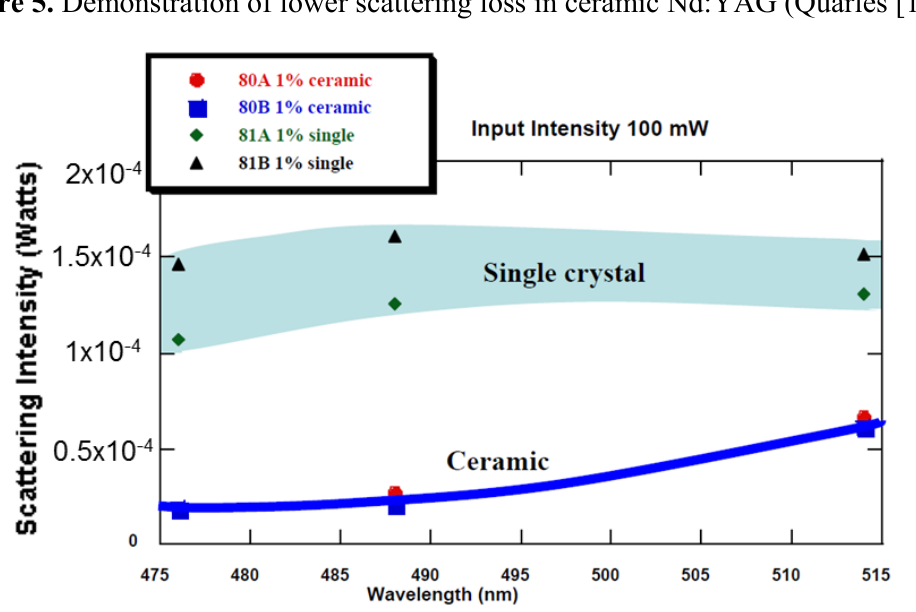
Figure 5. Demonstration of lower scattering loss in ceramic Nd:YAG (Quarles